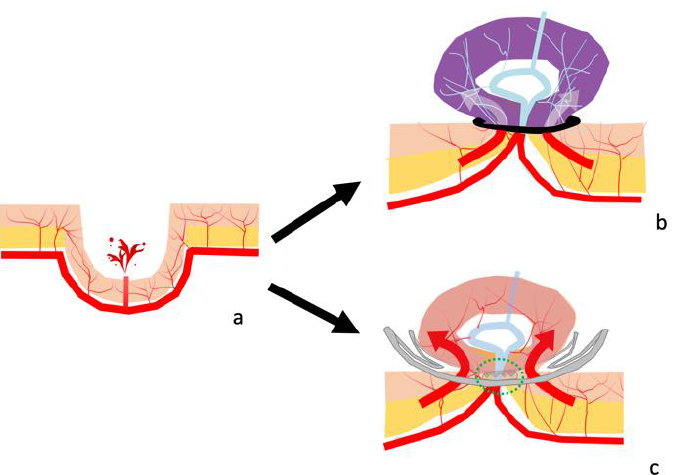
Figure 4. Schema of the endoscopic band ligation method (EBL) and over-the-scope clip method (OTSC). ( a ) Schema of colonic diverticular bleeding. ( b ) Schema after EBL. The diverticulum is ligated circumferentially by a band, and all of the blood vessels flowing into the inverted and bulged lesions are blocked (red and white arrow), causing ischemia. ( c ) Schema after an OTSC placement. The flow of the blood vessel captured by the OTSC is blocked (green circle), whereas the flow of other blood vessels through the space of the lateral sides of the OTSC to the colonic mucosa of the diverticulum remains (red arrow).